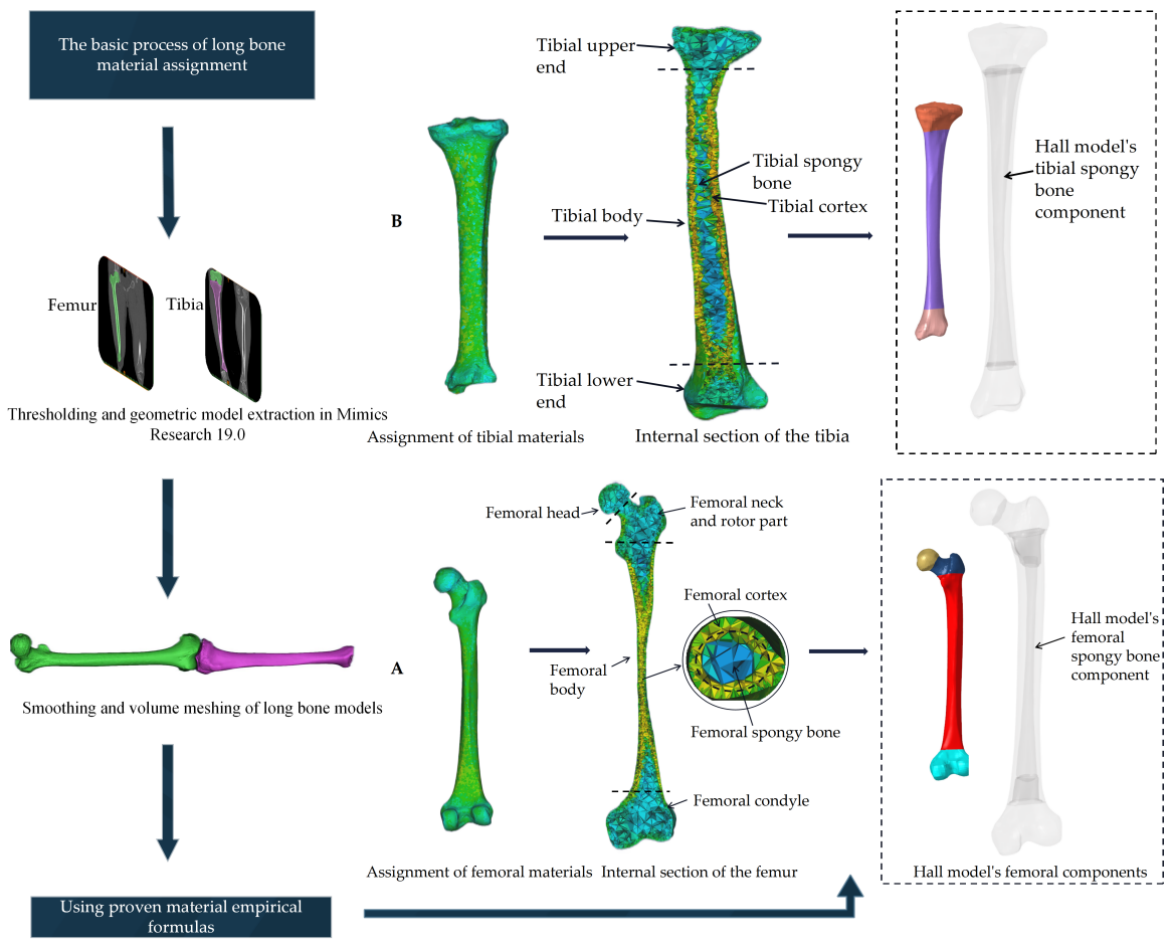
Figure 2. Extraction and material assignment process for long bone geometric models. ( A ) Material assignment of the femur. ( B ) Material assignment of the tibia